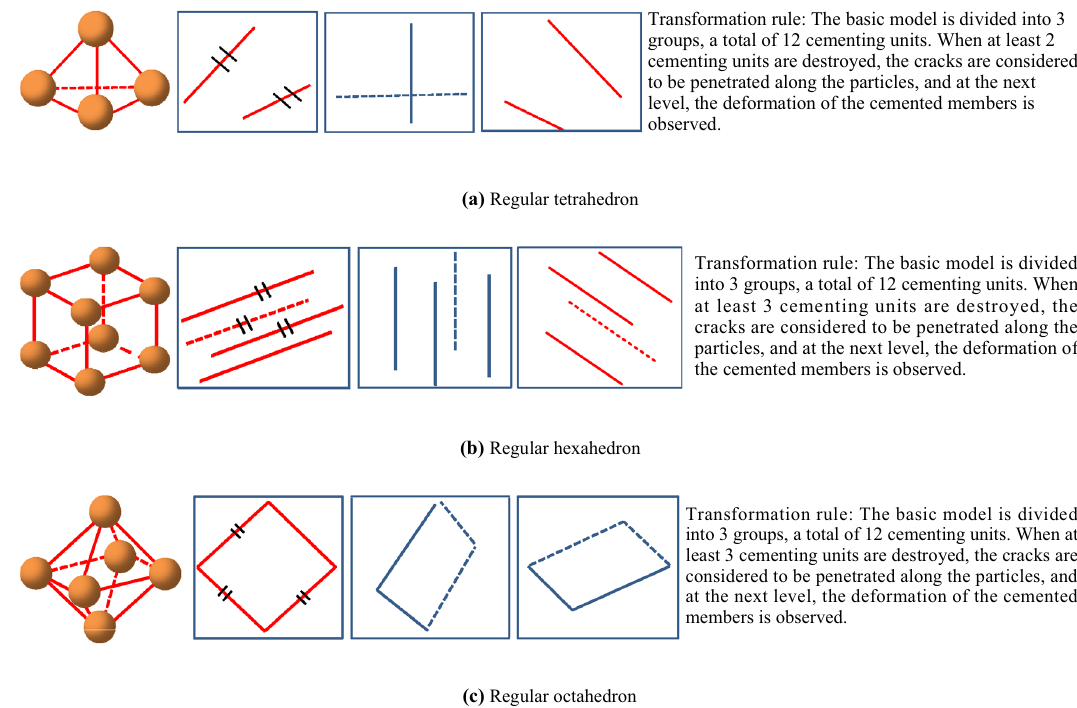
Fig. 7 Pore-centered microstructural units of weakly cemented sandstone: a regular tetrahedron, b regular hexahedron, c regular octahedron Table 1 Failure types of granule-centered microstructural units in weakly cemented sandstone Regular tetrahedra Regular hexahedra Regular octahedra Number of pieces of Number of Number of pieces of Number of Number of pieces of Number of ductile structural units that types of damage ductile structural units that types of damage ductile structural units that types of damage undergo damage to the unit undergo damage to the unit undergo damage to the